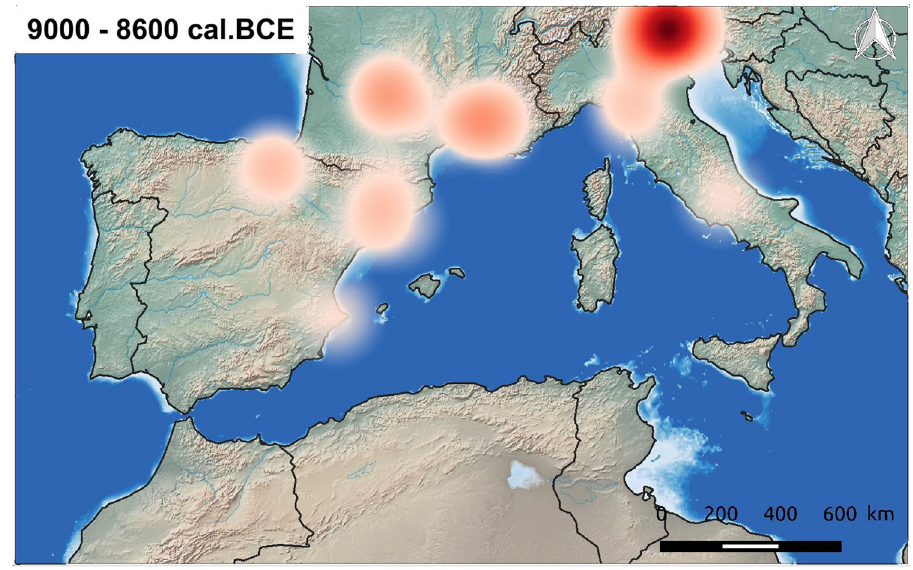
Figure 4: Heat map of the main earliest occupations of the Sauvterrian technocomplex, between 9500 and 8600 cal.